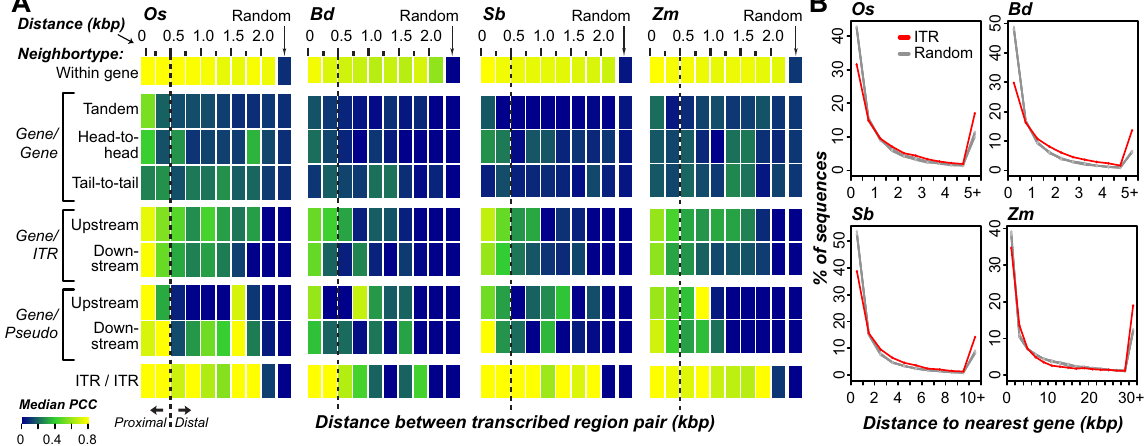
Figure 2. Expression correlation and distance between intergenic transcribed regions (ITRs) and neighboring genes. ( A ) Heatmaps of expression correlation between neighboring pairs of transcribed regions at various distance (kbp: kilobase pairs) in four species. Colors represent the median Pearson’s correlation coefficient (PCC) of expression levels (FPKM) across tissues between all transcribed regions pairs within a distance bin. Neighboring transcribed region pairs were classified according to whether they were in the same gene (Within gene), neighboring genes (Gene/Gene), genes and neighboring ITRs (Gene/ITR), gene and pseudogene neighbors (Gene/Pseudo), or neighboring ITRs (ITR/ITR). Random: based on 10,000 randomly-selected pairs of the same type. Neighboring gene pairs were sub-classified according to whether genes were oriented in the same direction (Tandem), or different directions with proximal 5 ′ (Head-to-head) or 3 ′ (Tail-to-tail) regions. Gene/Pseudo and Gene/ITR pairs were sub-classified according to whether the pseudogene or intergenic transcribed region was upstream or downstream of a gene neighbor. ( B ) Distance distributions between ITRs and their nearest genes (ITR) and randomly-selected intergenic regions of the same number and length distribution as ITRs in each corresponding species (five replicates, Random). Note the five randomly sampled distributions are highly